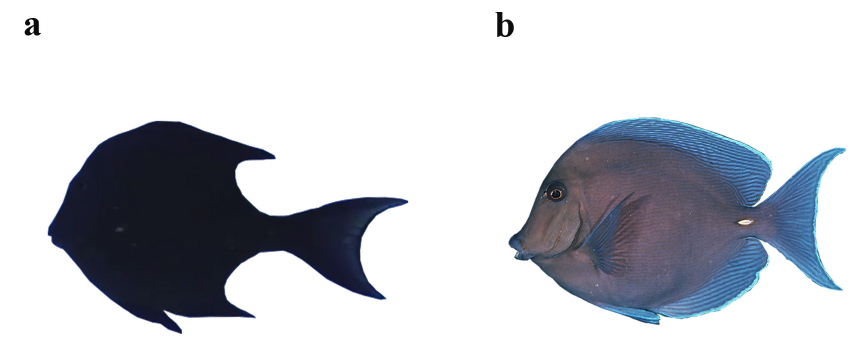
Figure 1 - Photographic comparison of: ( a ) Acanthurus coeruleus with dorsal and anal fin deformity observed in a coastal reef on northeastern Brazil; ( b ) normal profile of blue tang (adapted from Randall